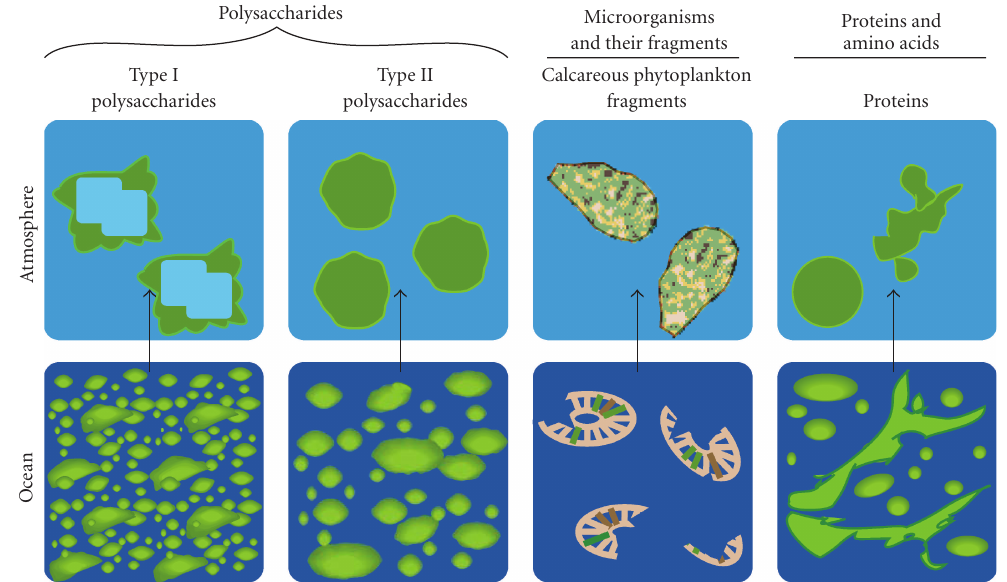
Figure 6: Illustration of the four observed marine particle types in the ocean and atmosphere.